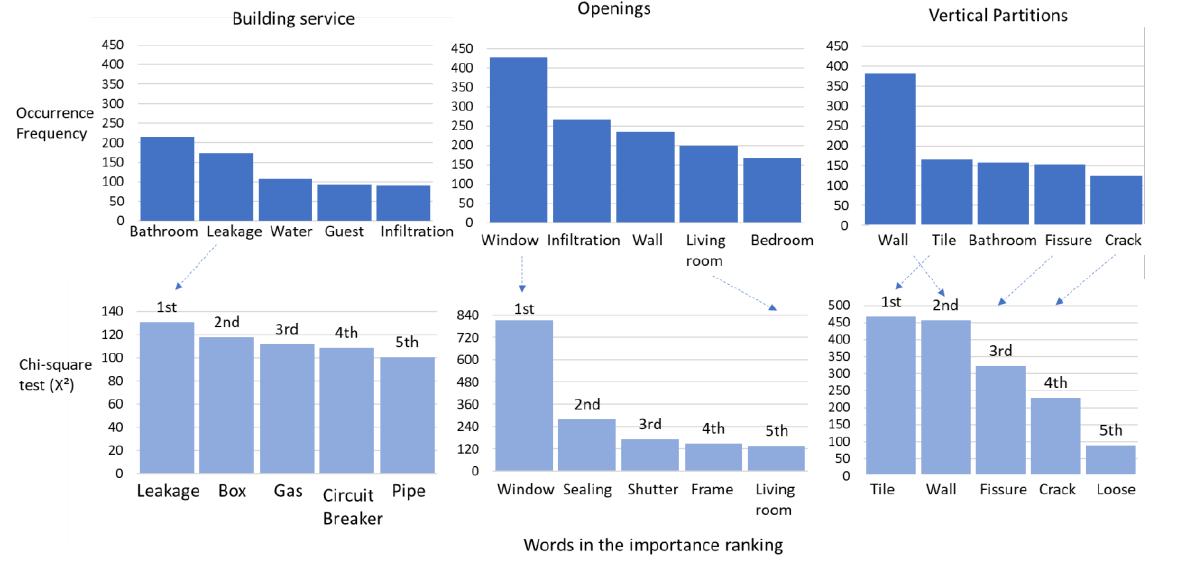
Figure 9. Keyness importance results. Table 3. Model performance.